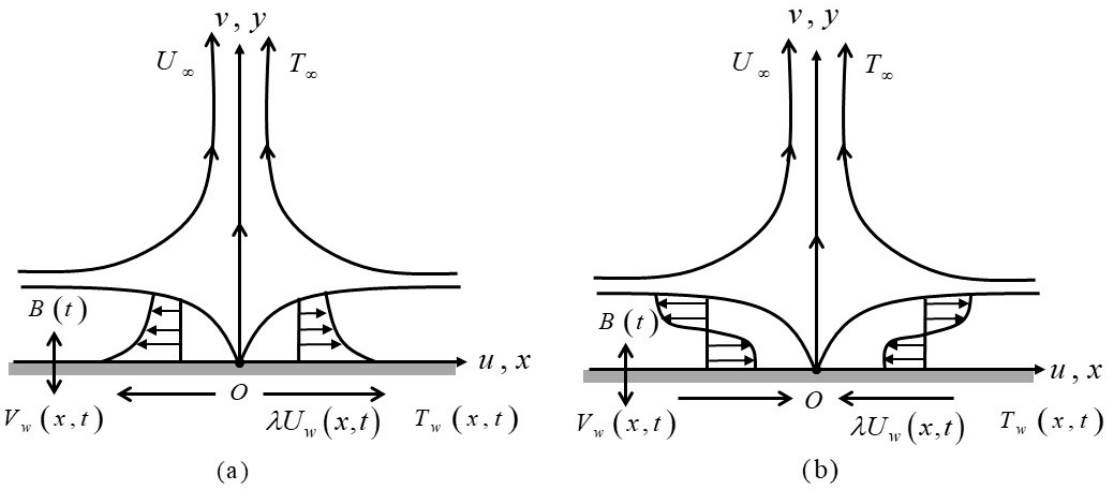
Figure 1. Physical models and coordinate systems: ( a ) stretching sheet ( b ) shrinking sheet. Table 1. The H 2 O, Al 2 O 3 and Cu thermophysical properties (see Abu Nada and Oztop [49]).